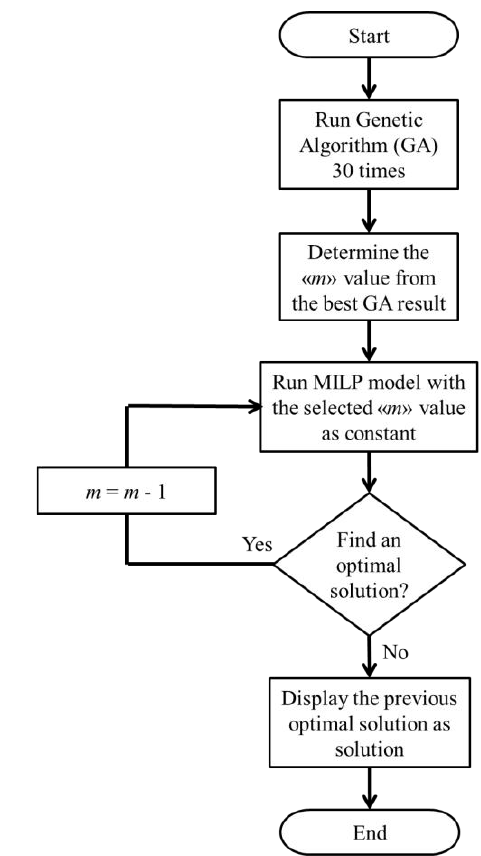
Figure 2. The flowchart of the proposed GABM.